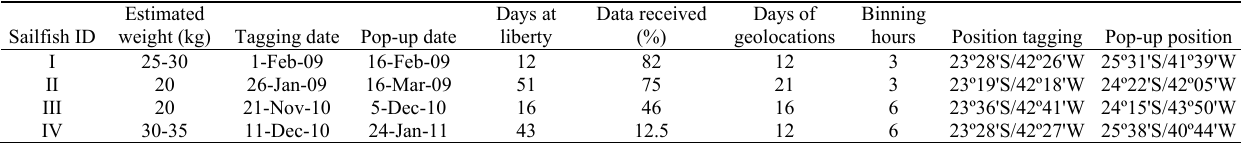
Table 1. Summary details for setup, release, pop-up and data received from pop-up satellite archival tags deployed on sailfish in